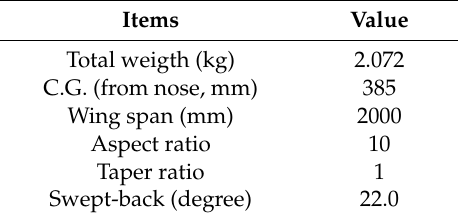
Table 1. Detailed parameters of BFF wind tunnel test on the